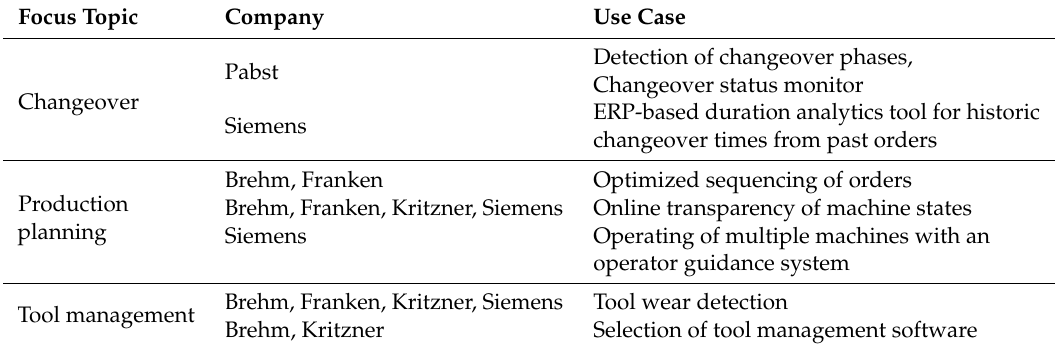
Table 2. Use cases of the partners of the OBerA